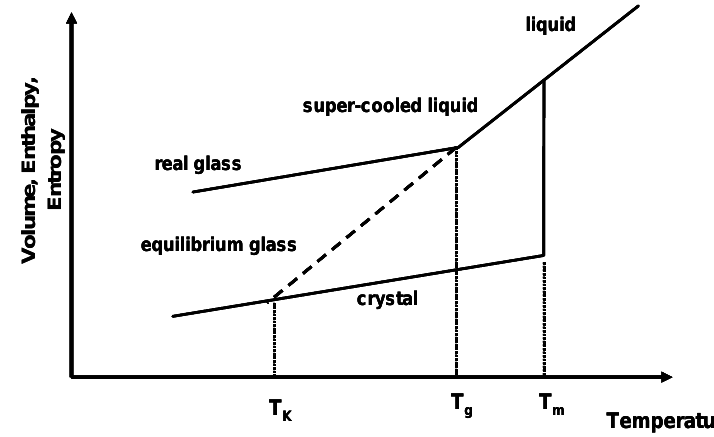
Figure 1. Thermodynamic relationship of crystalline and amorphous state as a function of temperature. Shown are the melting temperature ( T transition temperature ( T from